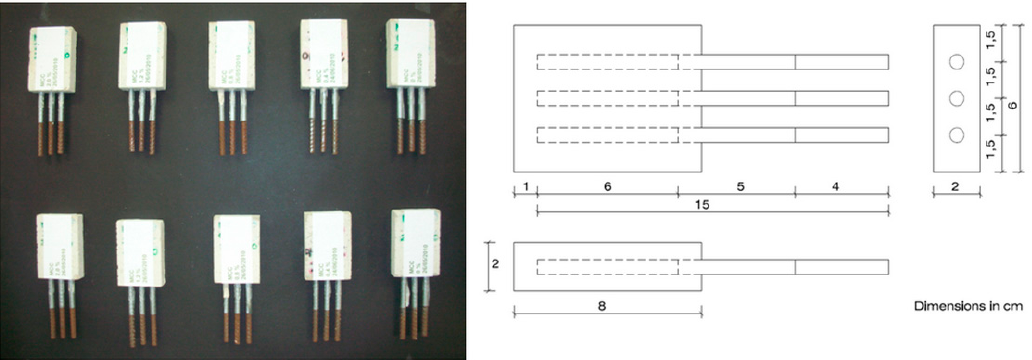
Figure 1. Geometrical characteristics of the specimens and specimens corresponding to the MCC